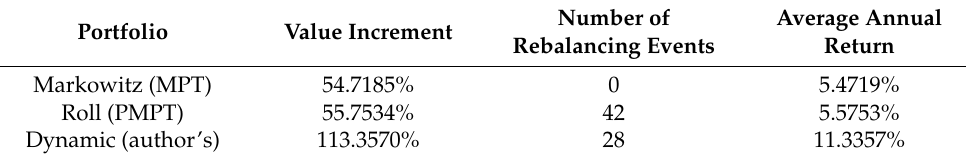
Table 8. Simulation modeling